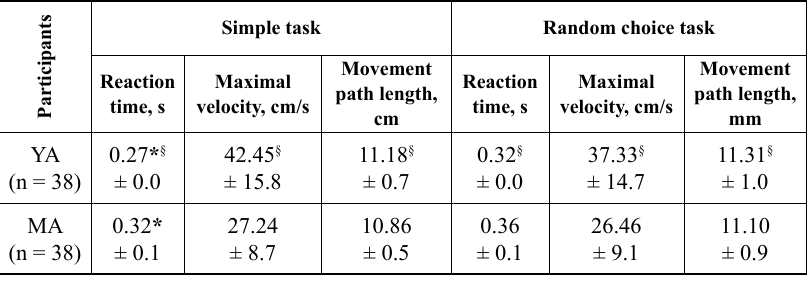
Table 2. Percentage values of motor task performance intra-individual variability between the groups of middle-aged and young adults